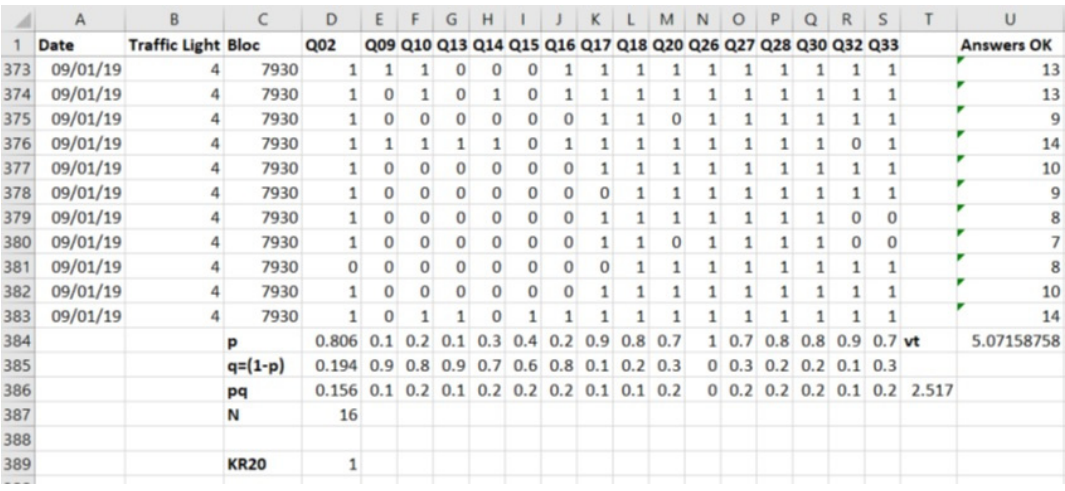
Figure 6. Excel screen using KR-20.